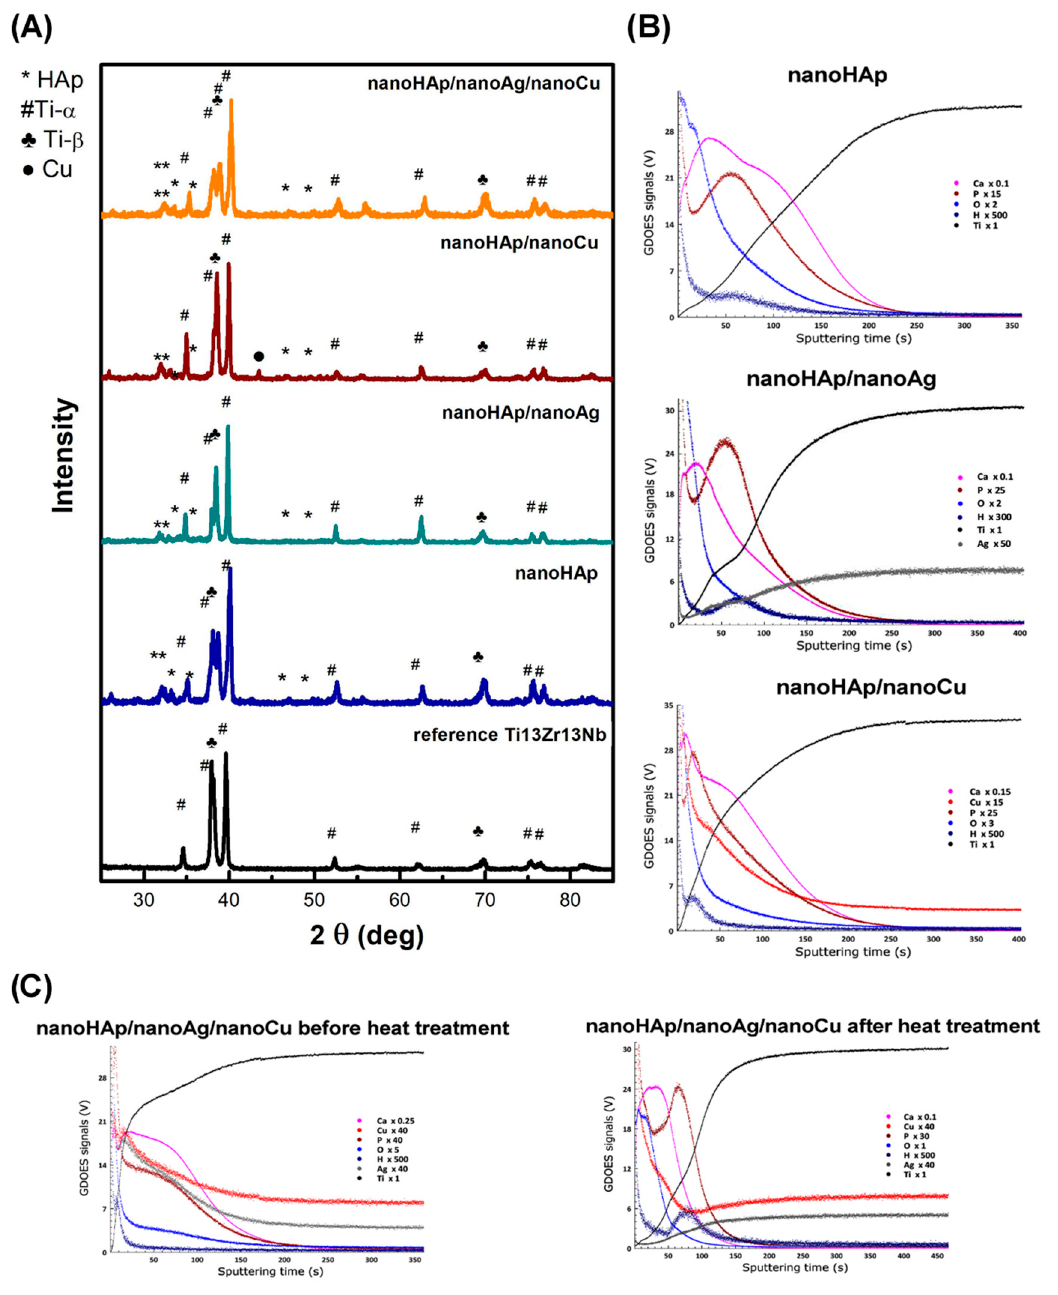
Figure 3. X-ray diffractograms of the reference Ti13Zr13Nb alloy and nanoHAp-based coatings ( A ) and glow discharge optical emission spectrometry (GDOES) graphs for tested coatings ( B , C ).